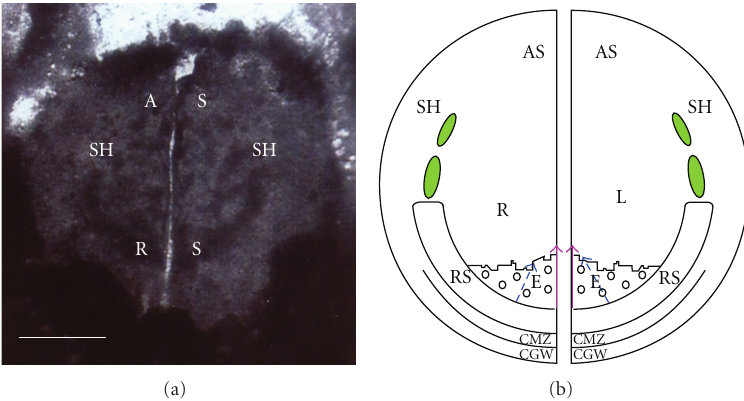
Figure 1: (a): Ventral view of living symmetrical halves of an unincubated chicken blastoderm, after hemisectioning through the middle part of the Rauber’s sickle (RS). AS, anti-sickle region where no Rauber’s sickle material is present; SH, sickle horn. Bar = 1mm. (b): Schematic representation of a symmetrically hemisectioned unincubated blastoderm as seen in Figure 1(a), to indicate its distinct components; AS, anti-sickle region; RS, half Rauber’s sickle; SH, sickle horns. Tops are colored in green since they are often fragmentary and not always distinctly visible. Although containing Rauber’s sickle material, they behave di ff erently from the median part of Rauber’s sickle. R, right hemi-blastoderm; L, left hemi-blastoderm; E, endophyll. The thick, red half-arrows represent the formation, after culture of hemi-primitive streaks at the cut edges of the blastoderm. CMZ, caudal marginal zone; CGW, caudal germ wall. The blue interrupted arrows indicate the localization of hypothetical symmetrical primitive streaks with reference to the half Rauber’s sickles, if only regulation phenomena would occur, according to the median line, going through the three elementary tissues in one half blastoderm.